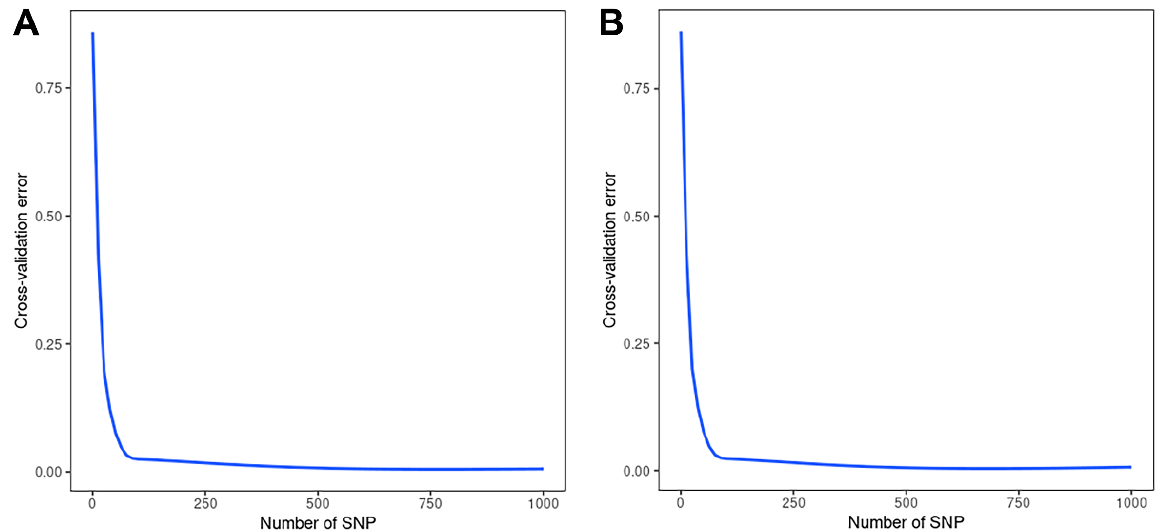
Figure 4. 10-fold cross-validation with 1K SNP panel in RF analysis. ( A ) 1K SNP panel selected by MDA; ( B ) 1K SNP panel selected by MDG